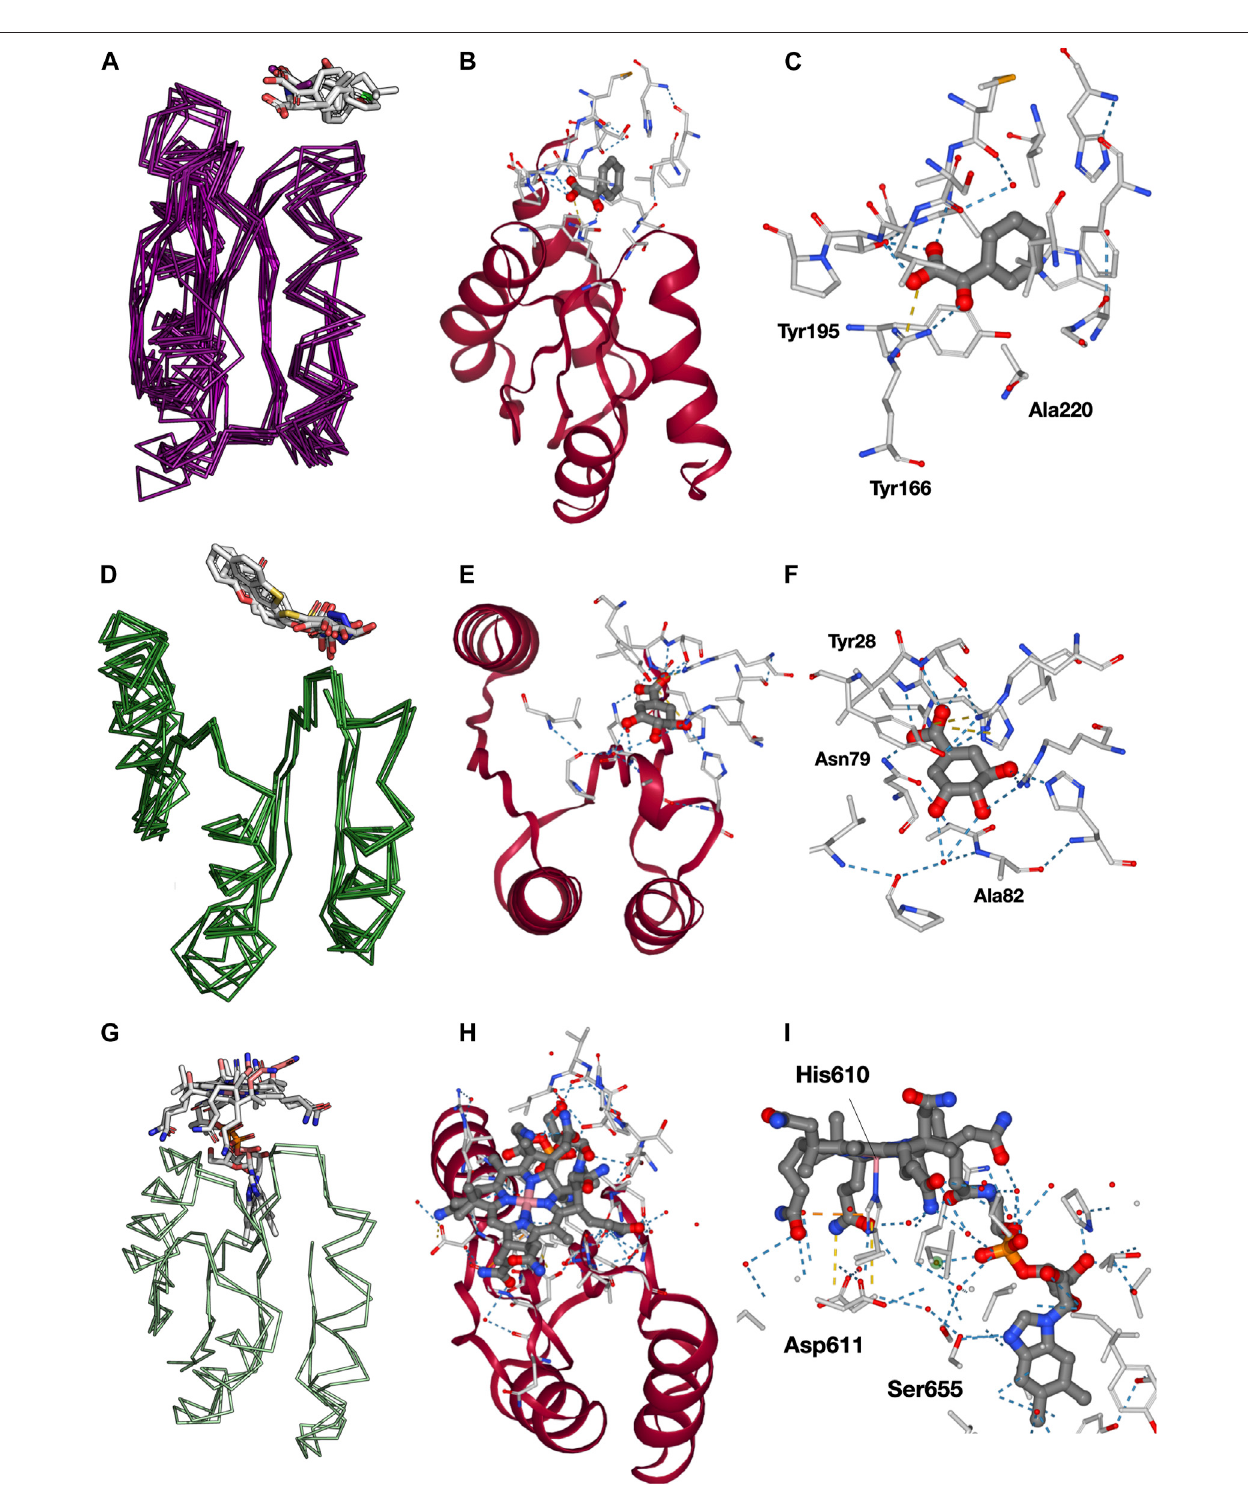
FIGURE3| Analysisofbindingmodesincluster13forsuperfamilyc.93.1,c.23.13, andc.23.6. (A) Domainsinc.93.1thatcontaincluster13and bindaligand. (B) Exampleoftyrosine(Tyr) bound todomain d3snra_ and its interactionswith cluster 13(red). (C) Closer viewonto the binding pocket (https://fuzzle.uni-bayreuth.de/2.0/ ligands/detailed/d3td9a_/135/219/. (D) Domains in c.23.13 that contain cluster 13 and bind a ligand. (E) 3-dehydroshikimate (DHK) bound to domain d1gtza_ and its interactions with cluster 13 (red). (F) Closer view on the binding pocket (https://fuzzle.uni-bayreuth.de/2.0/ligands/detailed/d1gtza_/6/81). (G) The two domains in c.23.6thatcontaincluster13andbindaligand. (H) Cobalamin(B12)boundtodomaind1reqa2_anditsinteractionswithcluster13(red). (I) Closerviewontothebinding pocket. Most of B12 interactions are performed within the fragment (https://fuzzle.uni-bayreuth.de/2.0/ligands/detailed/d1reqa2/598/687).